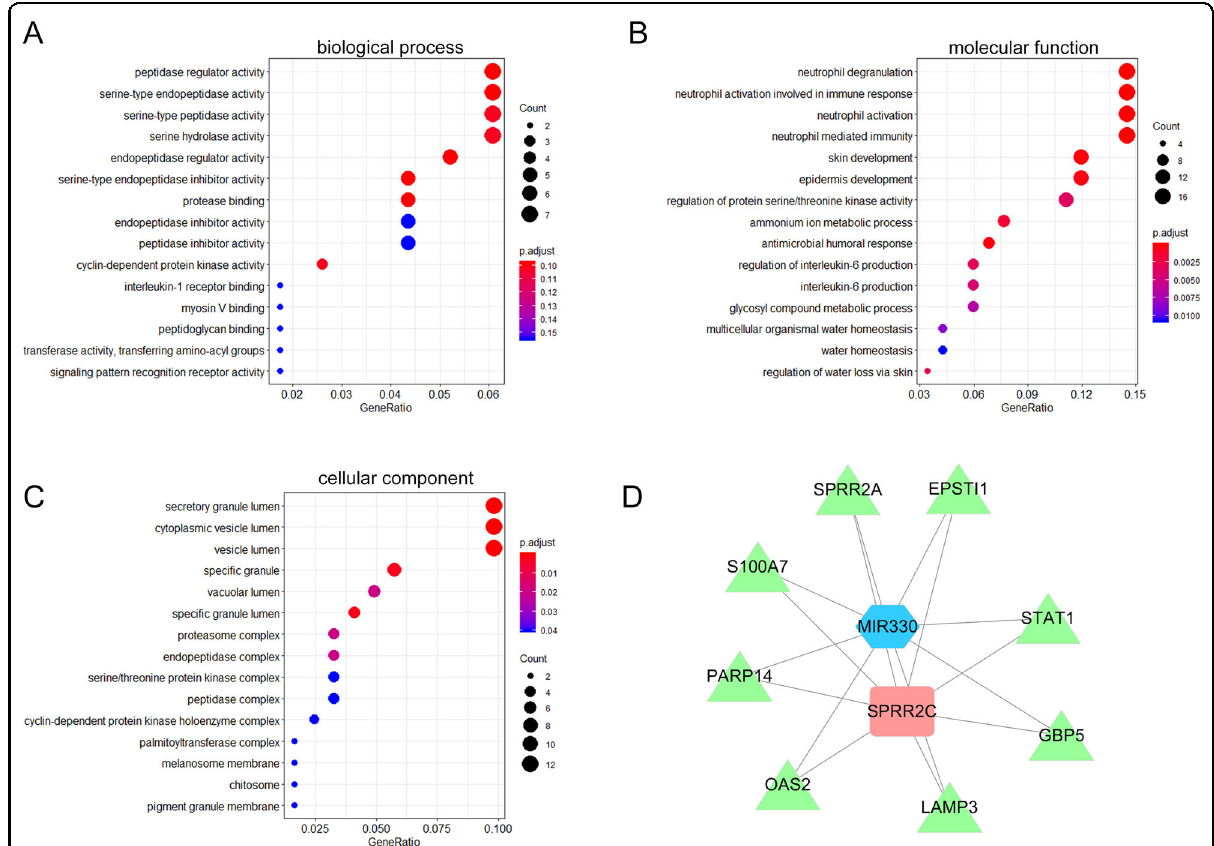
Fig. 3 Selection of miRNAs related to SPRR2C functions in IL-22-induced HaCaT cells. The coexpression network of SPRR2C was constructed based on data from GSE114286; coexpressed genes with SPRR2C were applied for Gene Ontology (GO) enrichment analysis. The results of the biological process (BP; A ), molecular function (MF, B ), and cellular component (CC, C ) analyses are shown. D Coexpression network of SPRR2C and negative correlation of SPRR2C with MIR-330 based on the data from